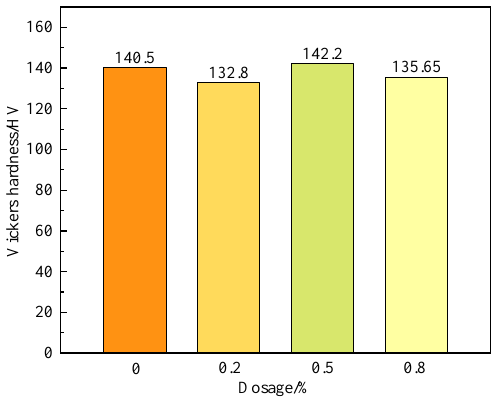
Figure 5. Effect of SHMP dosage on Vickers hardness of muscovite.